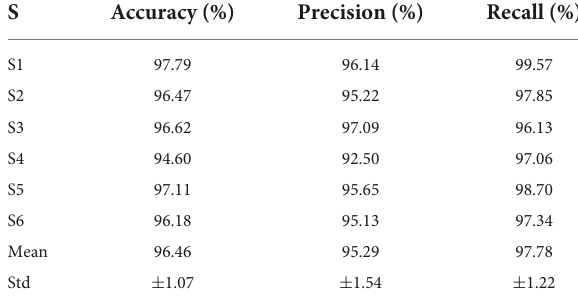
TABLE 8 The accuracy, precision and recall with scaled gaussian.